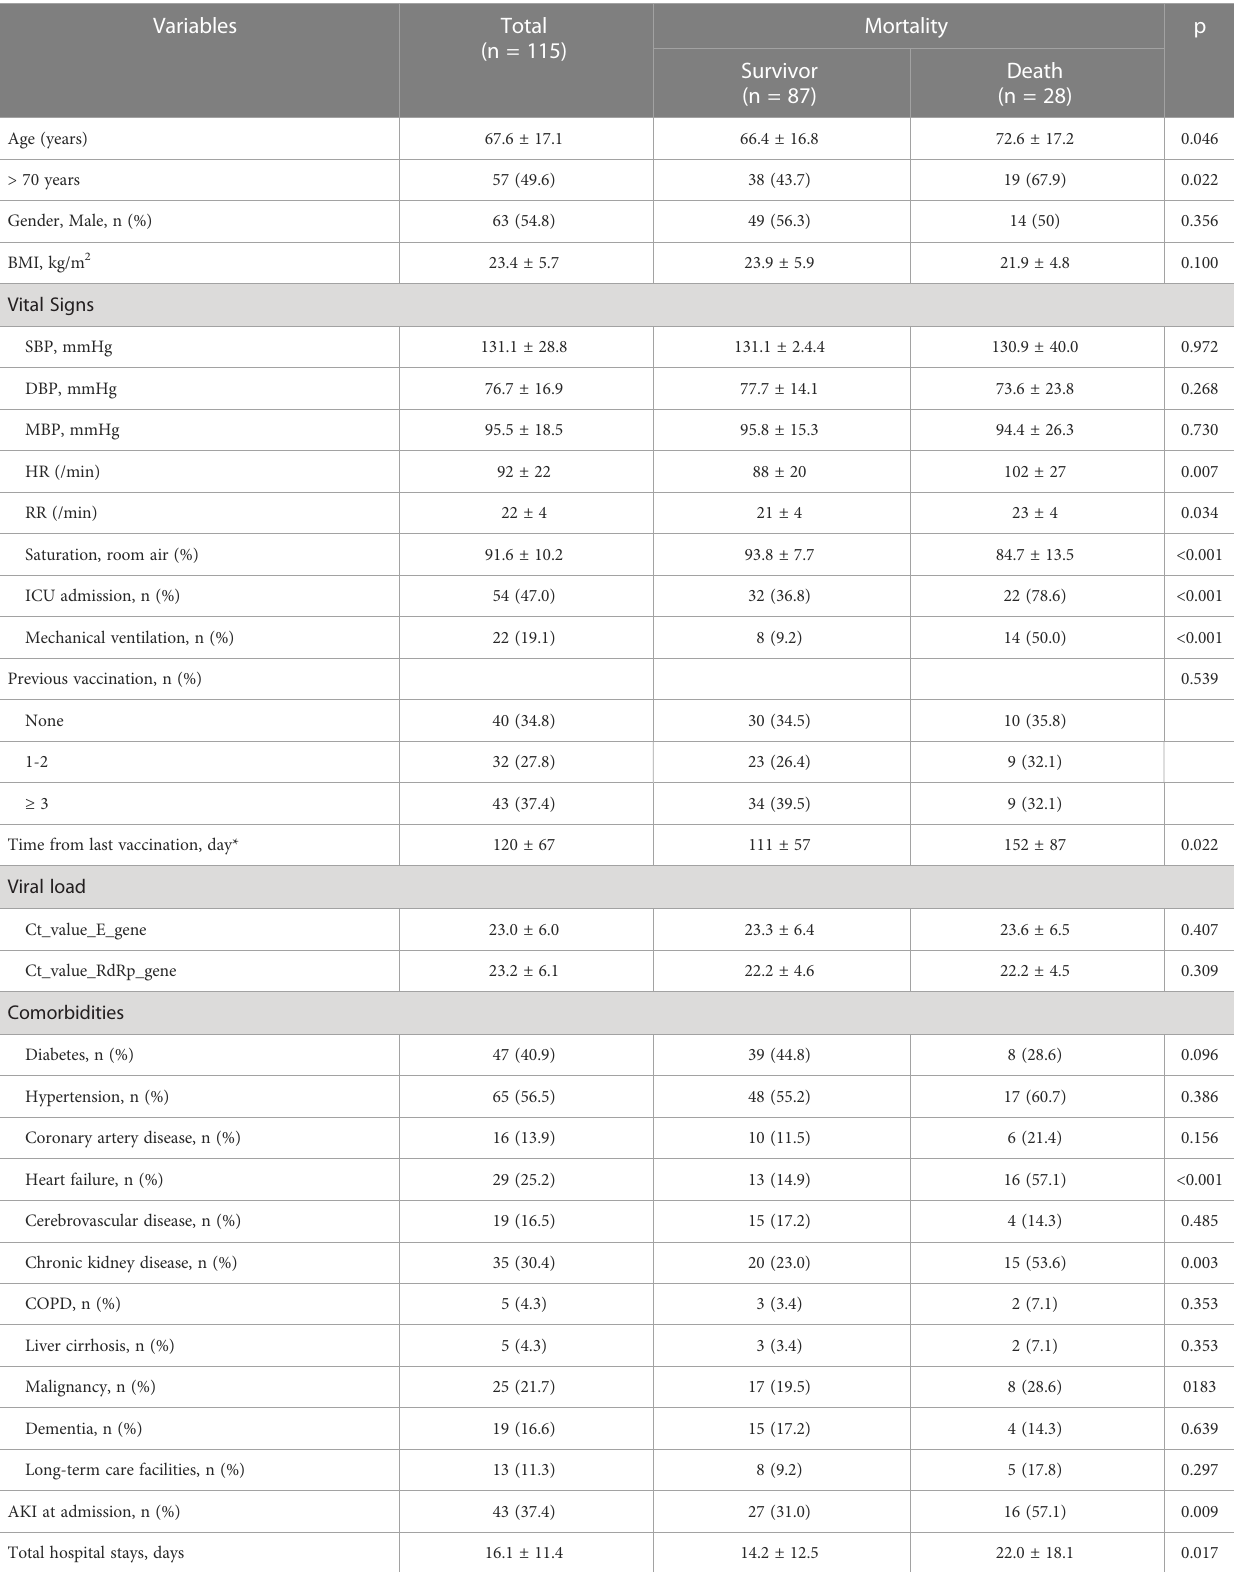
TABLE 1 Baseline characteristics according to